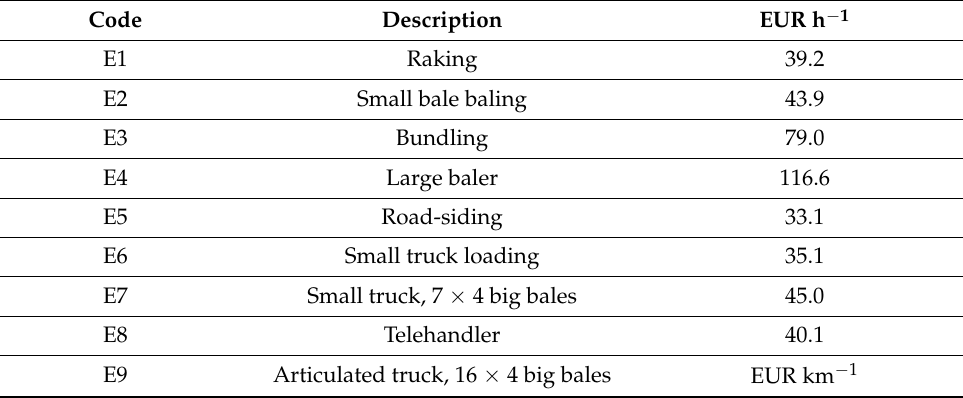
Table 4. Hourly costs (EUR h − 1 ) of the used